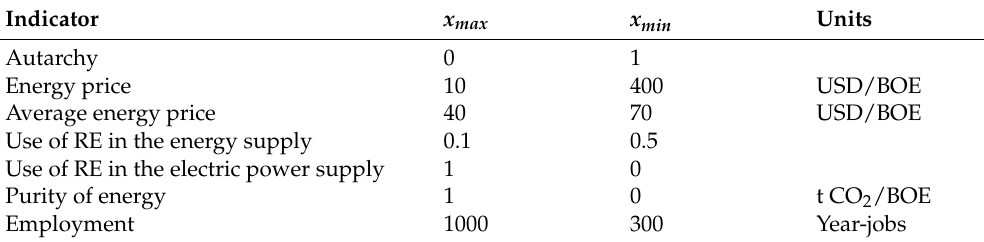
Table 4. The indicator standardization